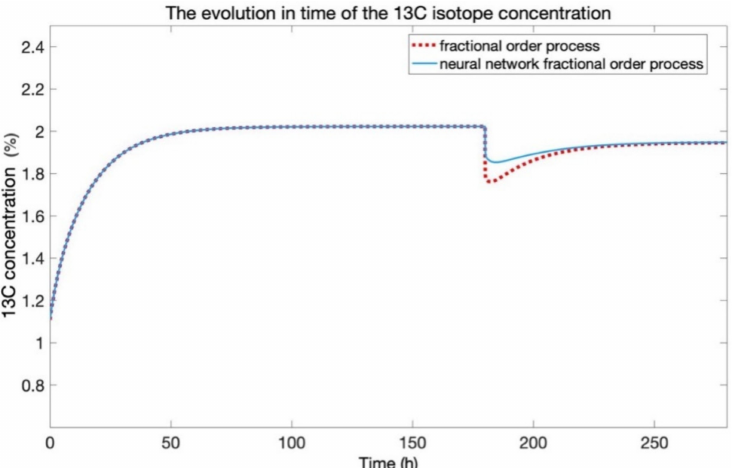
Figure 19. The proof of the proposed adaptive model efficiency in learning the increasing dynamics of the 13 C separation process when the fractional differentiation order varies decreasingly from β = 0.91 to β = 0.82 at t = 180 ( h ) .